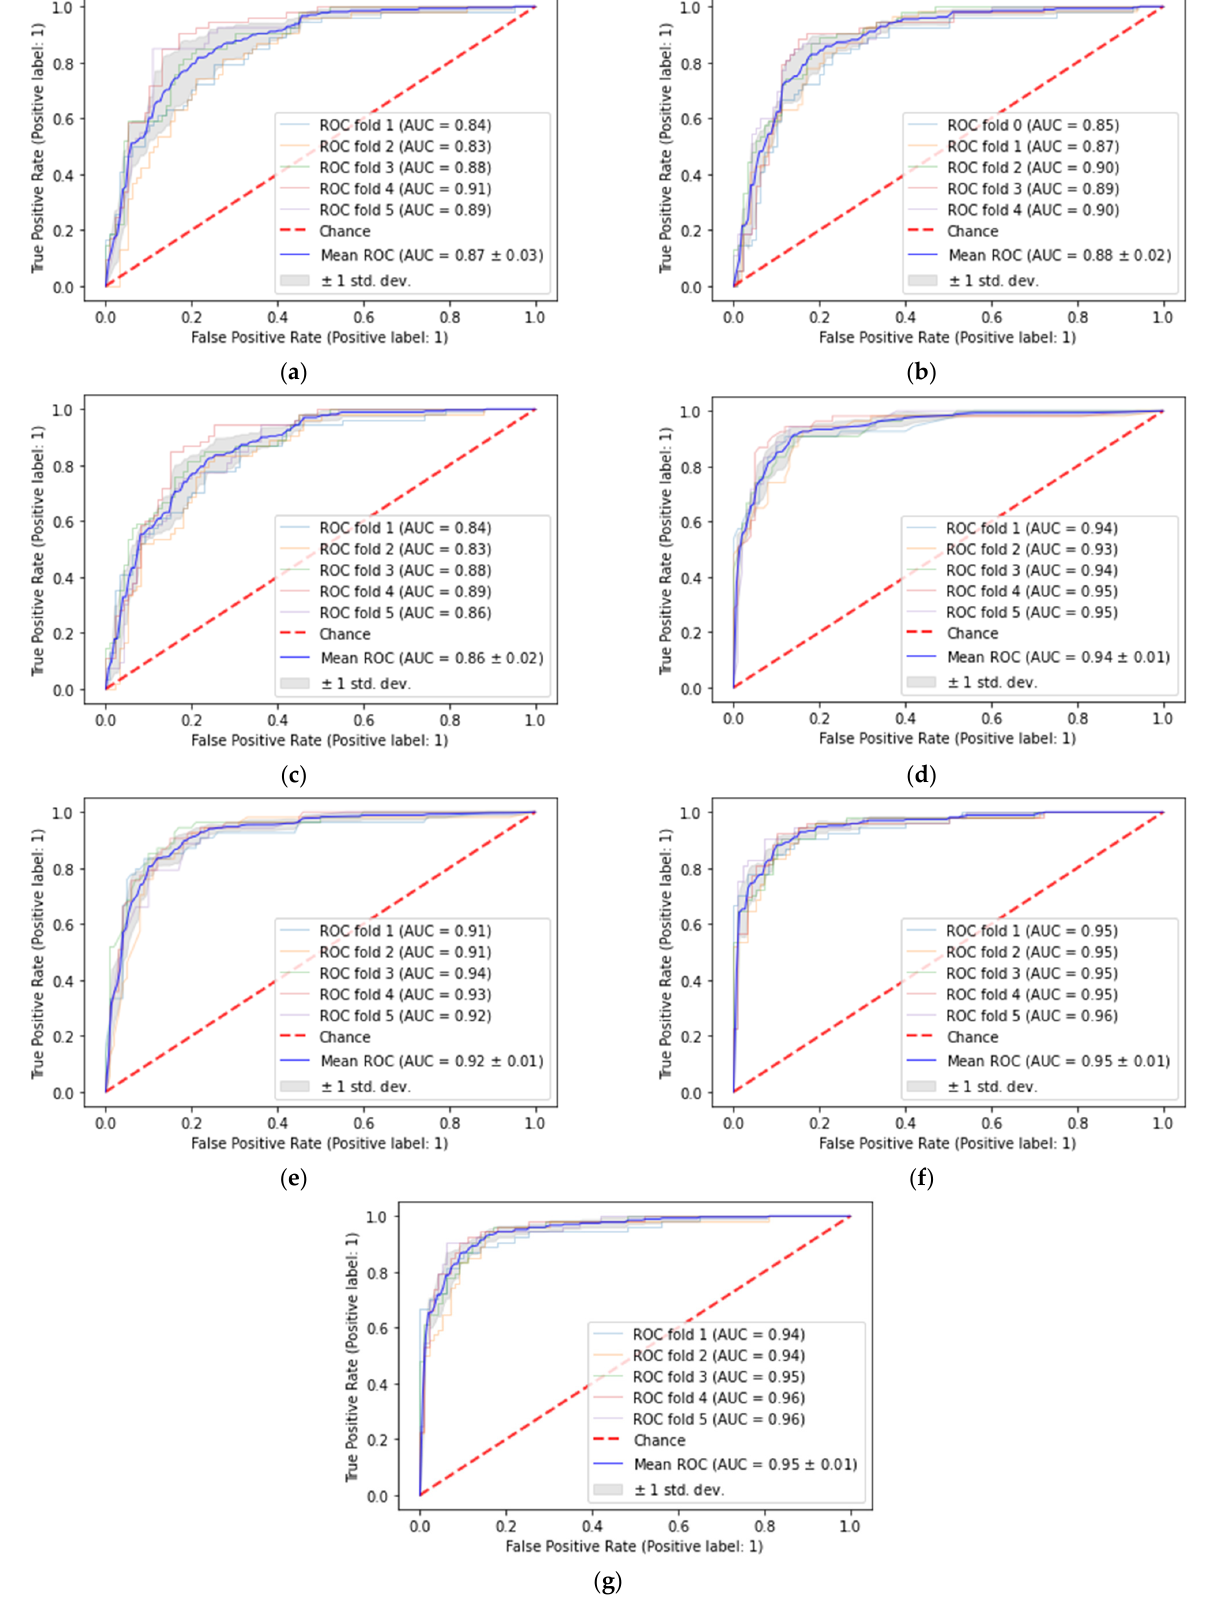
Figure 5. ROC curves of ( a ) ANN ( b ) SVM ( c ) LR ( d ) RF ( e ) ADA ( f ) XGB and ( g ) Voting classifier.